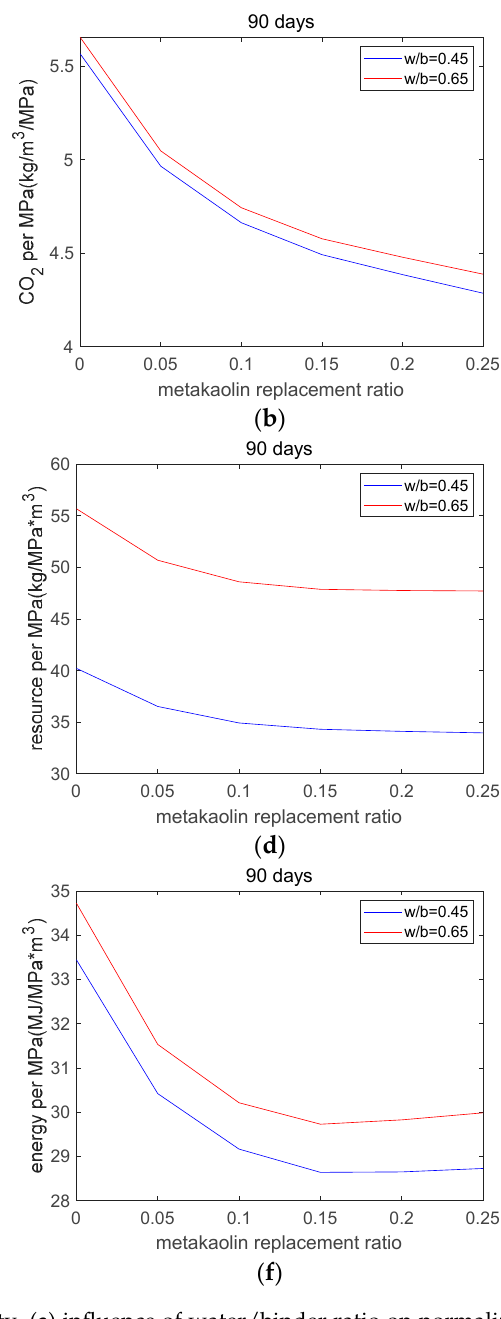
Figure 8. The influences of the water/binder ratio on sustainability. ( a ) influence of water/binder ratio on normalized CO 2 emissions—28 days. ( b ) influence of water/binder ratio on normalized CO 2 emissions—90 days. ( c ) influence of wa- ter/binder ratio on normalized resource consumption—28 days. ( d ) influence of water/binder ratio on normalized resource consumption—90 days. ( e ) influence of water/binder ratio on normalized energy consumption—28 days. ( f ) influence of water/binder ratio on normalized energy consumption—90 days.